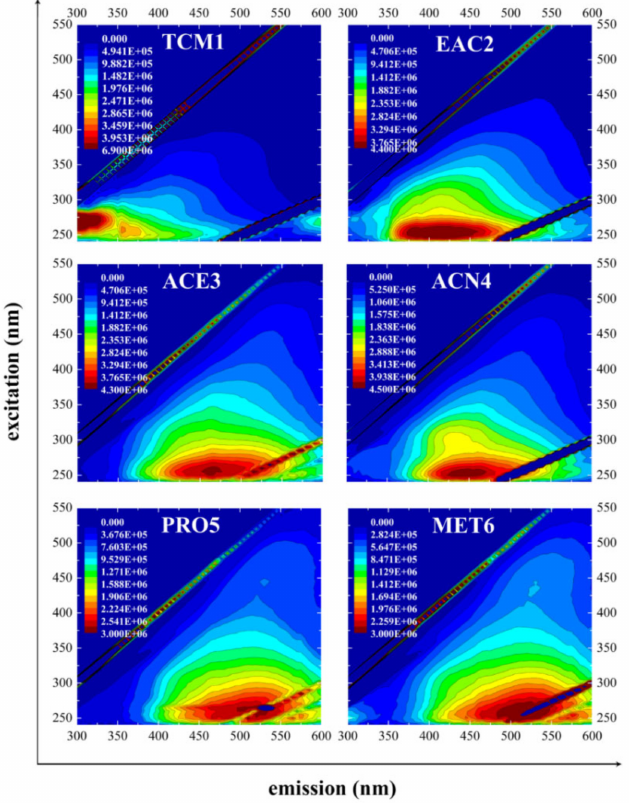
Figure 2. Excitation–emission matrix (EEM) spectra of organic fractions extracted from peat